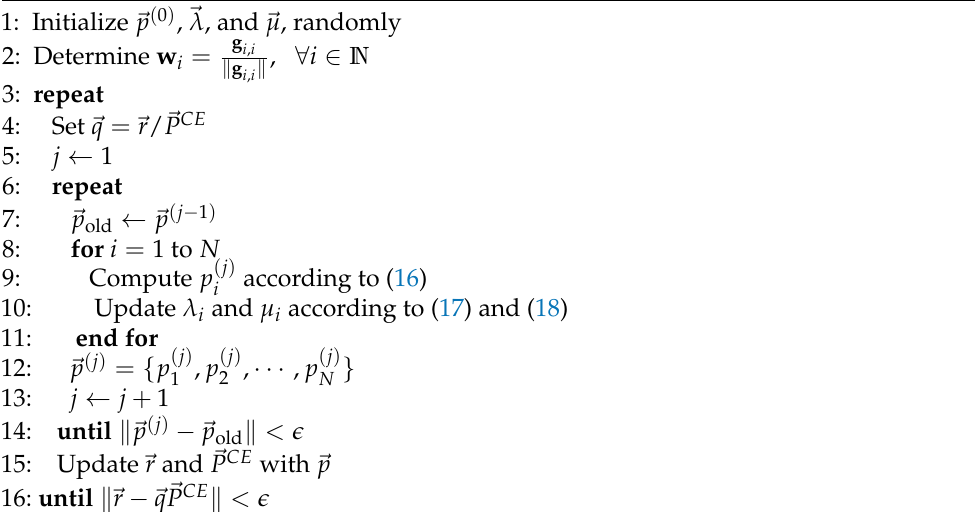
Algorithm 1 Energy-efficient beamforming and power